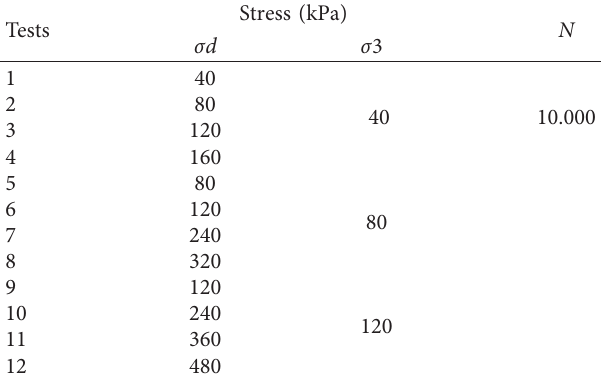
Table 1: Relation of the stress used in triaxial repeated load